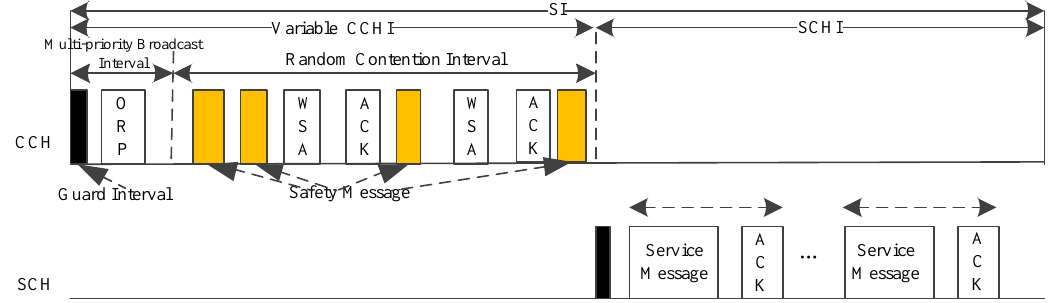
Figure 11. Time structure of APDM.